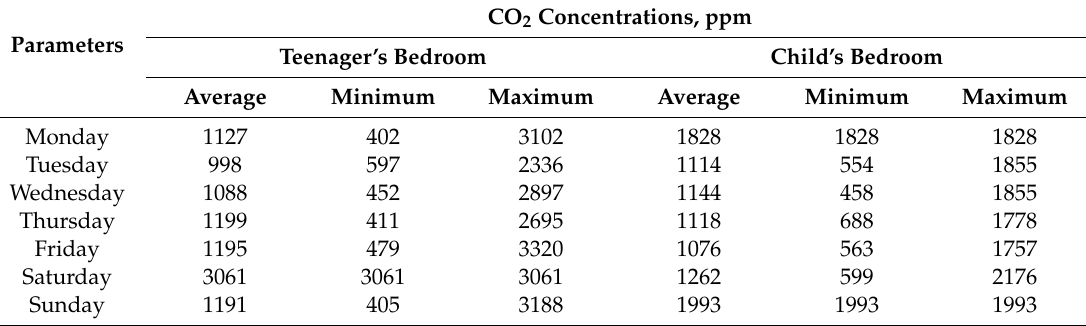
Table 1. Average, minimum, and maximum CO 2 concentrations according to the day of the week.